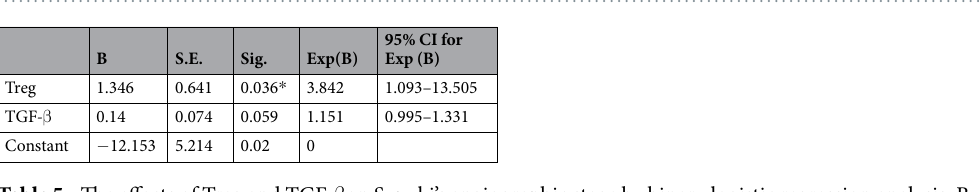
Table 5. The effects of Treg and TGF- β on Suzuki’s angiographic stage by binary logistic regression analysis. B, coefficients; SE, SEM; Exp(B), OR; * P <